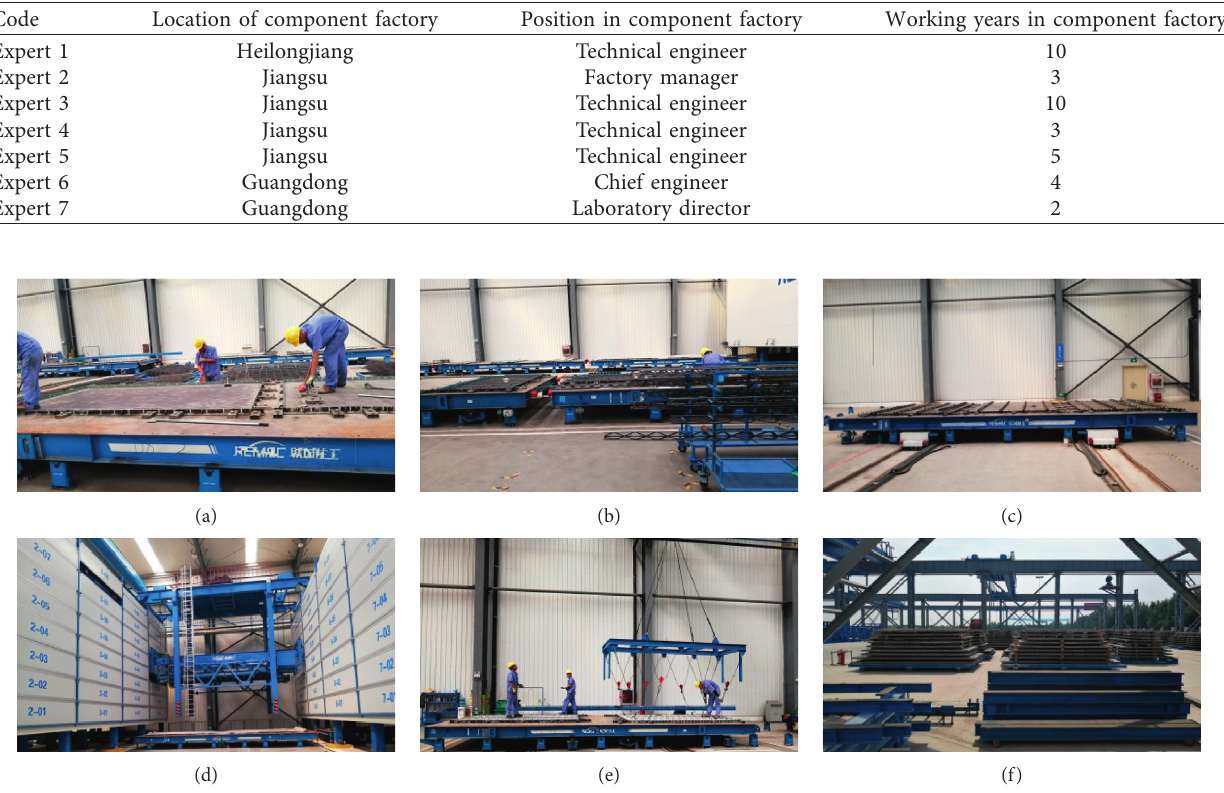
Figure 1: Production process of a component factory under investigation. (a) Cleaning workstation. (b) Steel installation workstation. (c) Resting workstation. (d) Curing kiln. (e) Mold releasing workstation. (f) Stacking